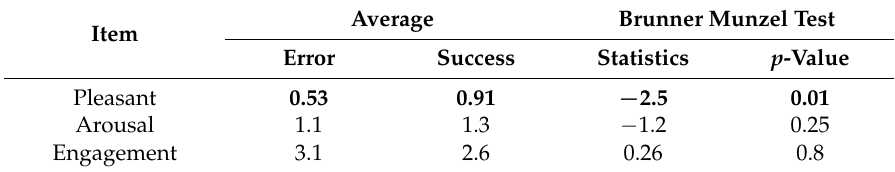
Table A3. Effect of pleasant emotion, arousal, and engagement on human error.